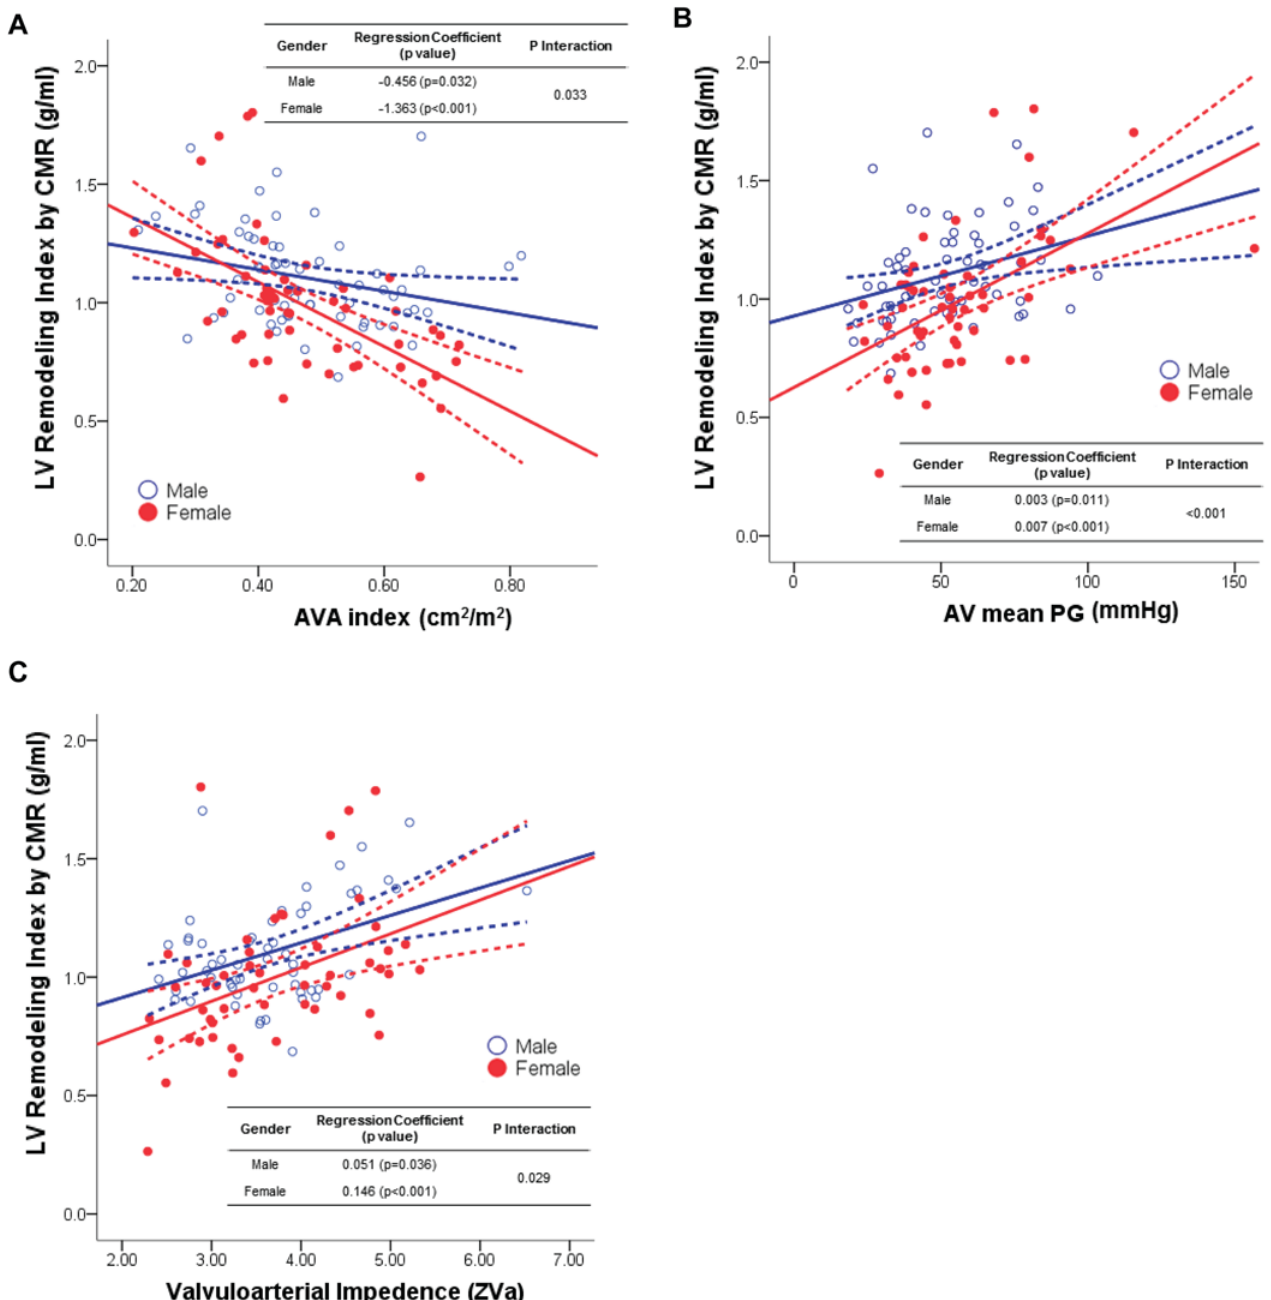
Fig 2. The association between left ventricular remodeling index and the severity of aortic stenosis or valvuloarterial impedance. Males consistently showed relatively higher left ventricular remodeling index in (A) larger aortic valve area index, (B) lower mean transaortic pressure gradient, or (C) lower valvuloarterial impedance, compared with females. However, there were significant differences between the two genders in the degree of correlation between the left ventricular remodeling index and the above three parameters. The univariate linear regression coefficient and the interaction p value across the gender are shown. Abbreviations: AV, aortic valve; AVA, aortic valve area; CMR, cardiovascular magnetic resonance; PG, pressure gradient.